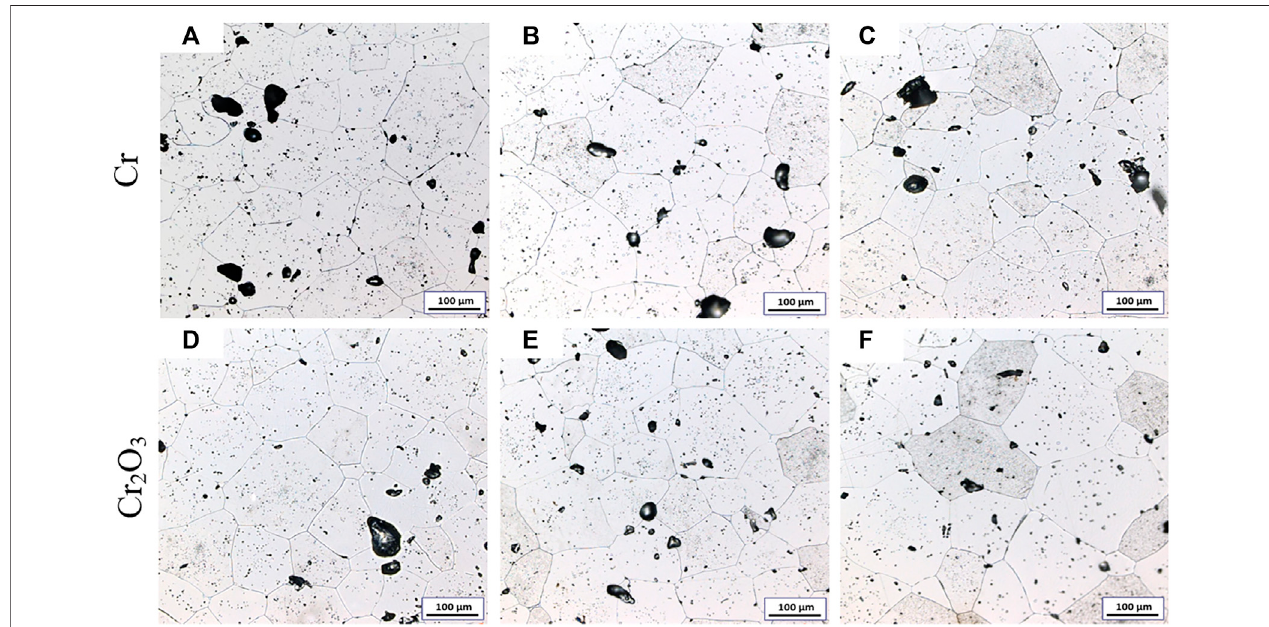
FIGURE 4 | Grain morphologies of Cr and Cr 2 O 3 doped UO 2 sintered under different pressing pressures. (A) Cr-100 MPa; (B) Cr-200 MPa; (C) Cr-300 MPa; (D) Cr